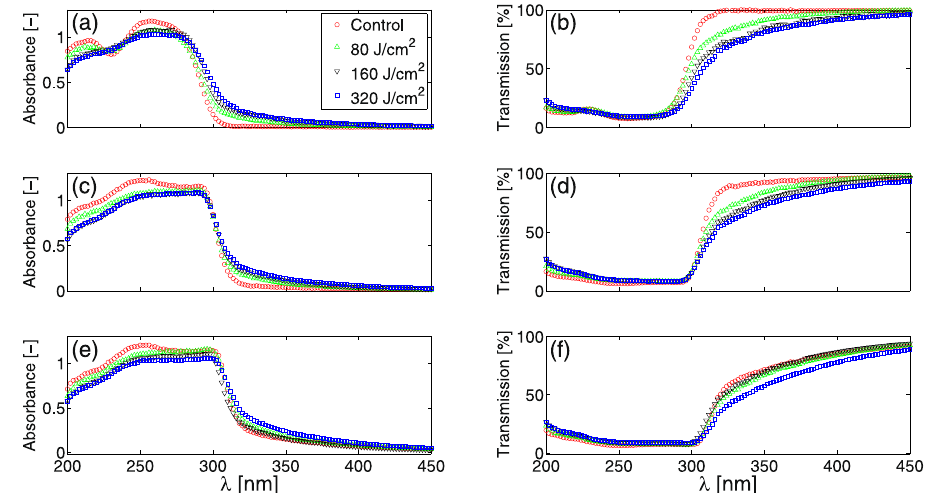
Figure 4. Effects of UVA irradiation. Absorbance (left column) and transmission (right column) plotted against wavelength, λ , for films with a surface density of 0.0031 mg/mm 2 (top row), 0.0124 mg/mm 2 (middle row) and 0.031 mg/mm 2 (bottom row). Each of the panels ( a – f ) display the average (n = 3 individual films for each dosage) absorbance or transmission spectrum prior to UVA irradiation (Control: red circle) and after UVA dosages of 80 J/cm 2 (green triangle), 160 J/cm 2 (black inverted triangle) and 320 J/cm 2 (blue square). Standard deviations in all cases are smaller than the symbol size and have not been plotted to improve visual clarity.